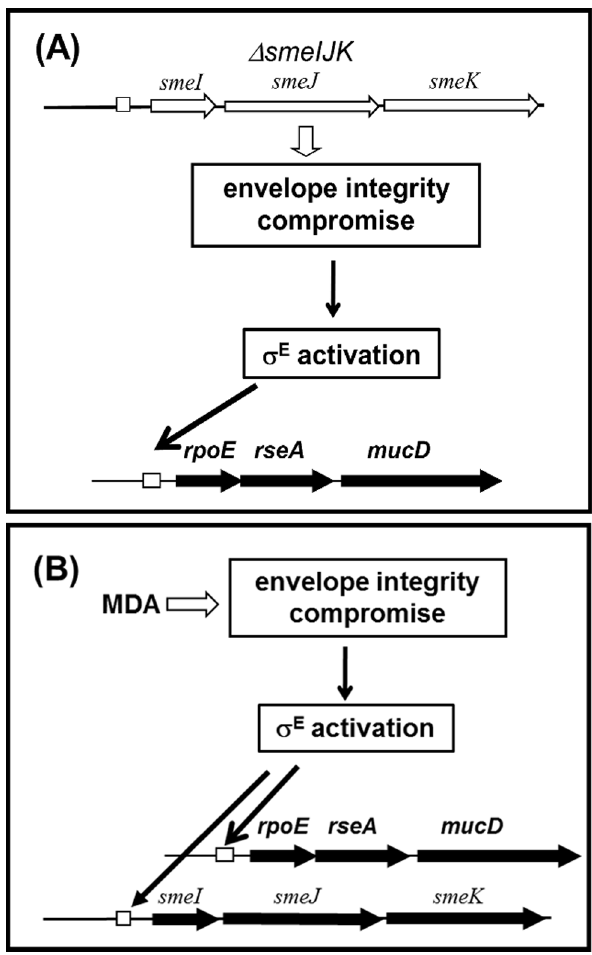
Figure 7. The involvement of smeIJK and membrane damaging agents (MDAs) in the s E -mediated envelope stress response (ESR) of S.maltophilia . (A) Deletion of smeIJK compromises the cell envelope integrity and activates the rpoE to alleviate the envelope stress. (B) The treatment of MDAs on the wild-type cells activates rpoE system and upregualtes smeIJK expression. SmeIJK operon is a member of rpoE regulon.